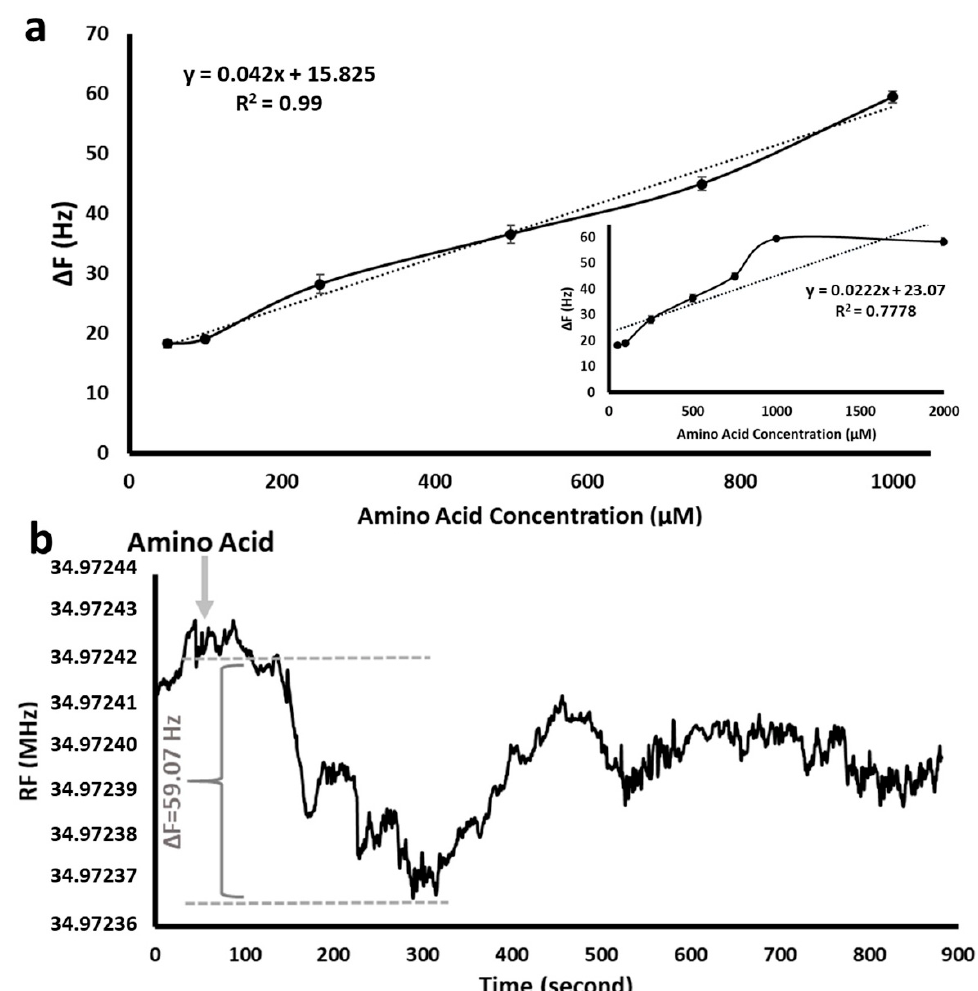
Figure 5. Frequency shift in SAM 11-MUA-modified QCM nanosensor effect of amino acid (Phe) initial concentration (50–1000 µM); T: 20 °C, pH: 7 ( a ) Frequency shift in SAM 11-MUA-modified QCM nanosensor effect of amino acid (Phe) initial concentration (50–2000 µM); T: 20 °C, pH: 7 (( a ), inset) and a typical sensogram of 1000 µM of amino acid adsorption onto QCM nanosensor ( b